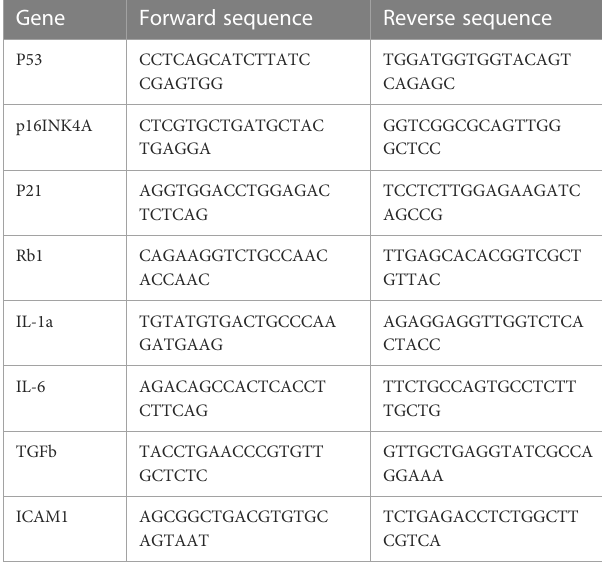
TABLE 1 The primers used for qPCR